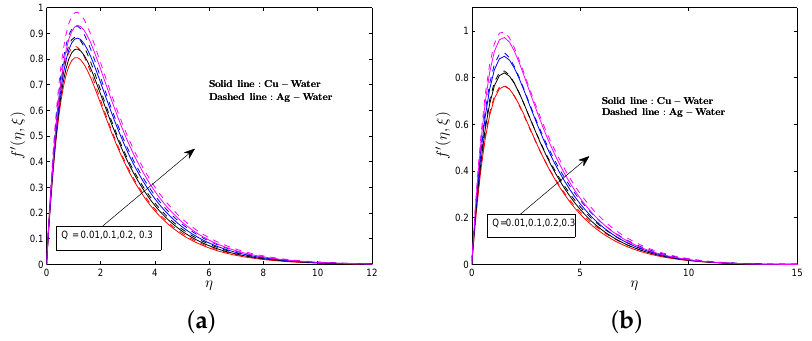
Figure 6. Velocity profiles for various values Q . ( a ) vertical plate; ( b ) horizontal